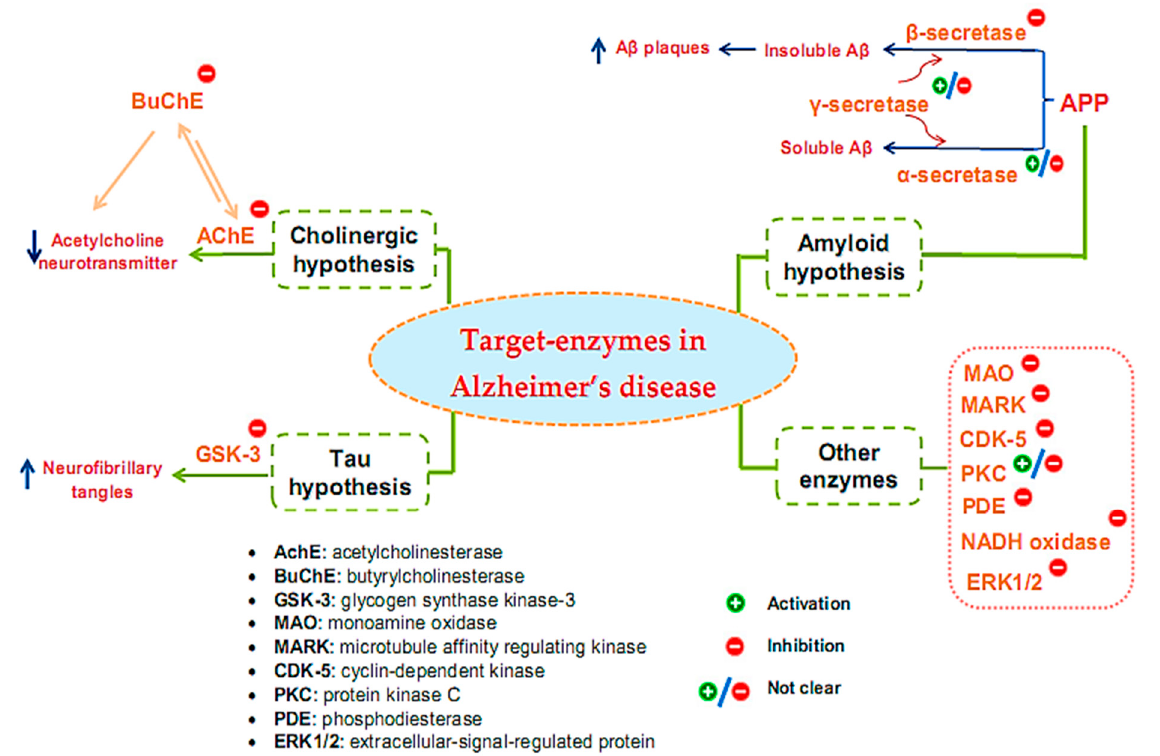
Figure 1. Target enzymes related to the pathogenesis of Alzheimer’s disease.